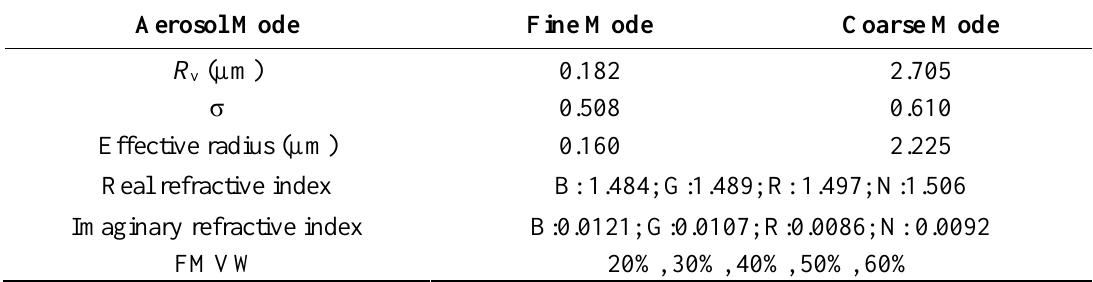
Figure 3. Aerosol volume size distributions of the 22 cases obtained from the closest AERONET retrievals within half an hour of satellite overpass for Beijing. The wider red line stands for the average size distribution from 2005 to 2009. Table 1. Detailed parameters of the assumed aerosol models